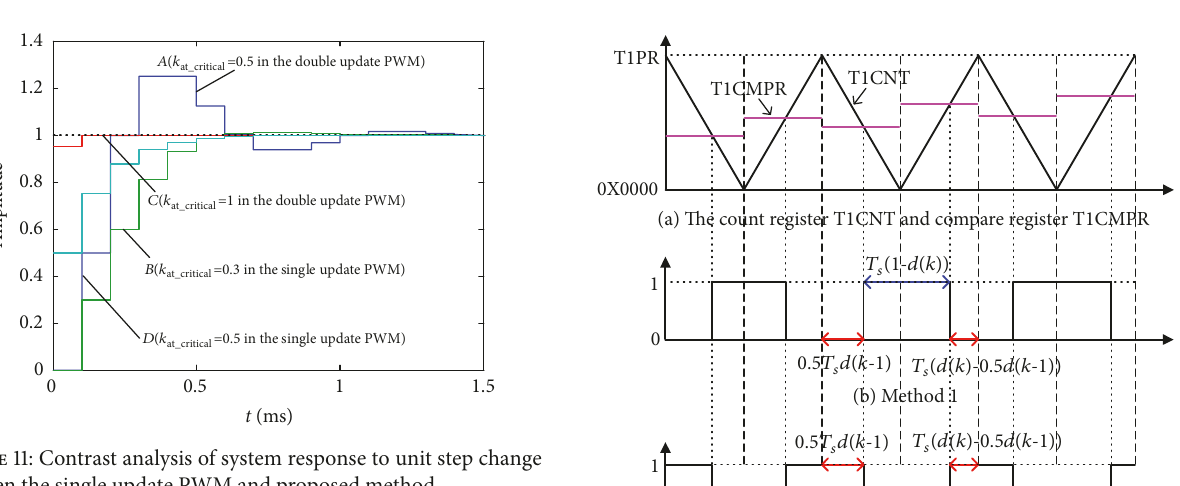
Figure 10: Proposed control system response to unit step change with the constant sampling frequency f 𝑘 changes. at critical